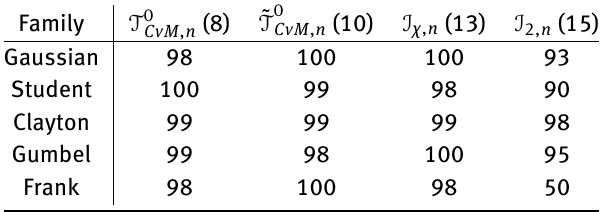
Table 2: Rejection percentages under the alternative (nonparametric tests, nonparametric bootstrap